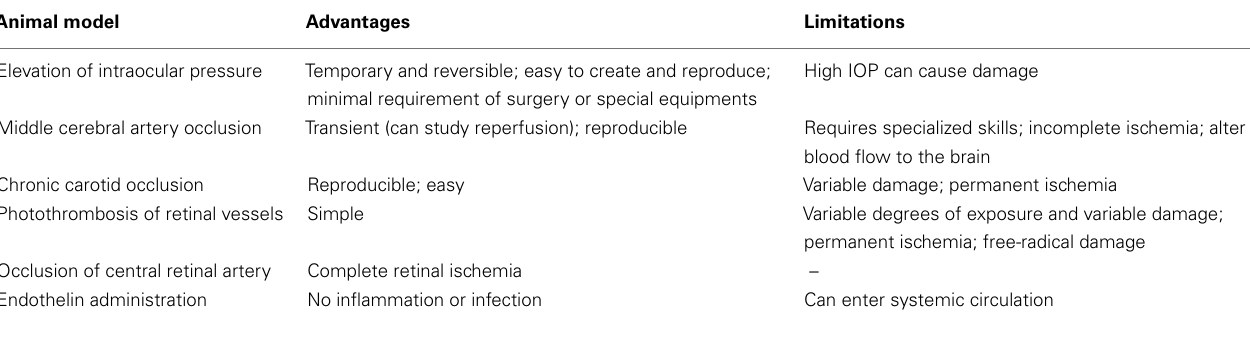
Table 1 |Advantages and limitations of different animal models of retinal